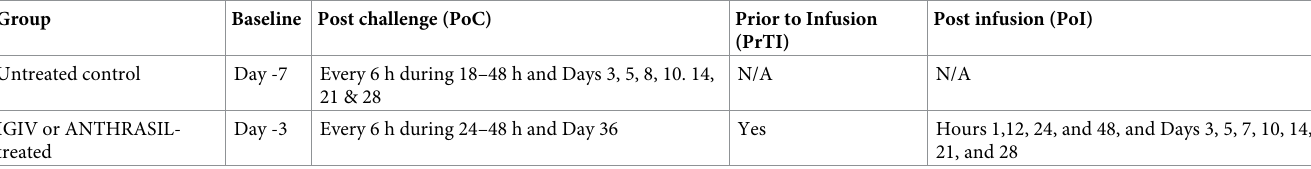
Table 1. Schedule of blood collection in rabbit therapeutic efficacy study. Group Baseline Post challenge